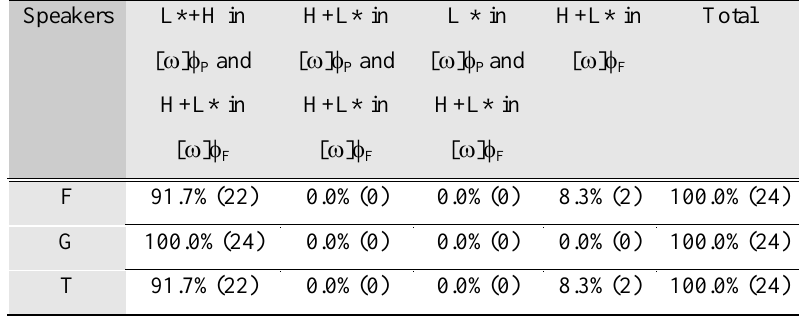
Table IV. Tonal events associated with the  s of the penult and the I-final non-branching 